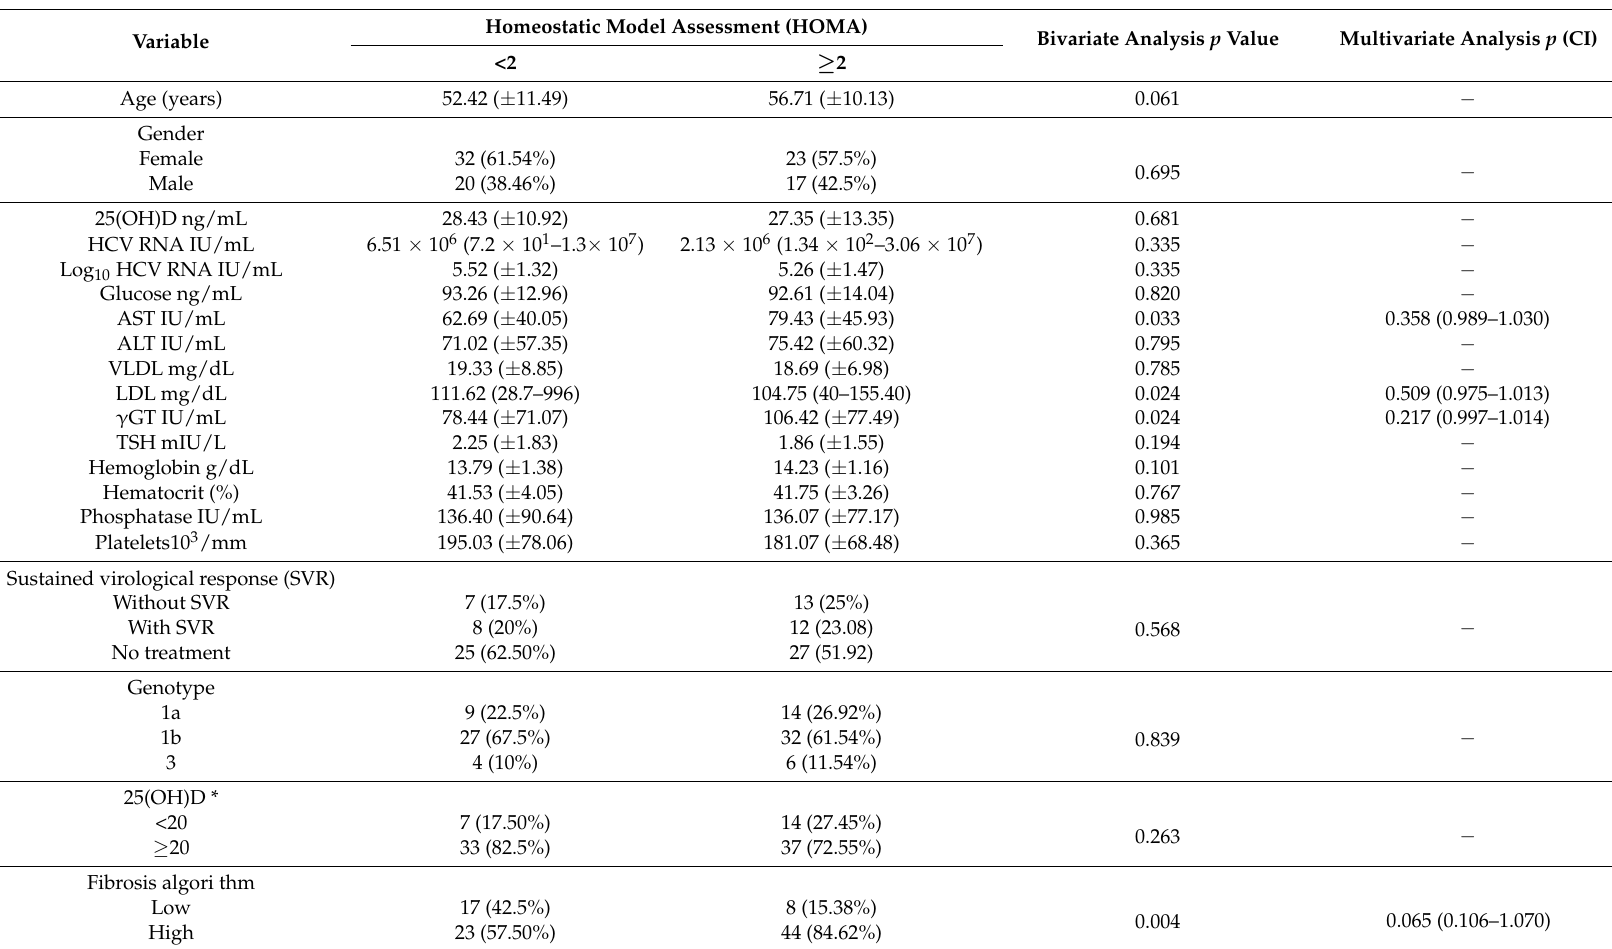
Bivariate Analysis p